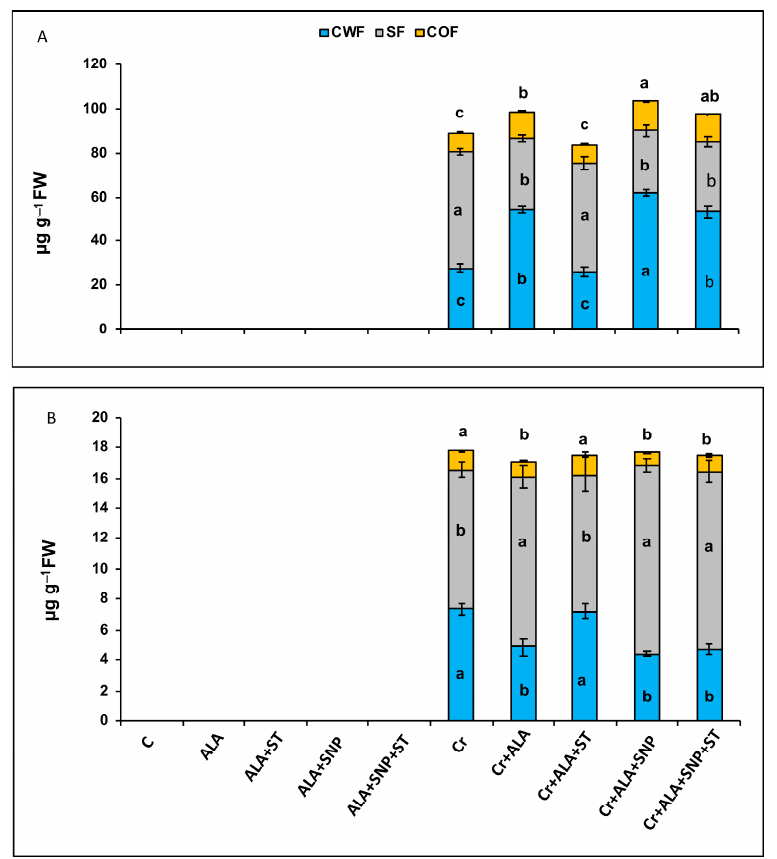
Figure 5. The cell wall fraction (CWF), cell organelle fraction (COF), and vacuolar soluble fraction (SF) of chromium (Cr) in roots ( A ) and leaves ( B ) in Cr-treated (+Cr) and non-treated ( − Cr) tomato seedlings sprayed with 20 mg L − 1 5-aminolevulinic acid (5-ALA), 0.1 mM sodium tungstate (ST) + 5-ALA, 5-ALA + 0.1 mM sodium nitroprusside (SNP), or 5-ALA + SNP + ST. Data are means ± S.E, different lower-case letters on bars reflect that mean values differ significantly at p ≤ 0.05.